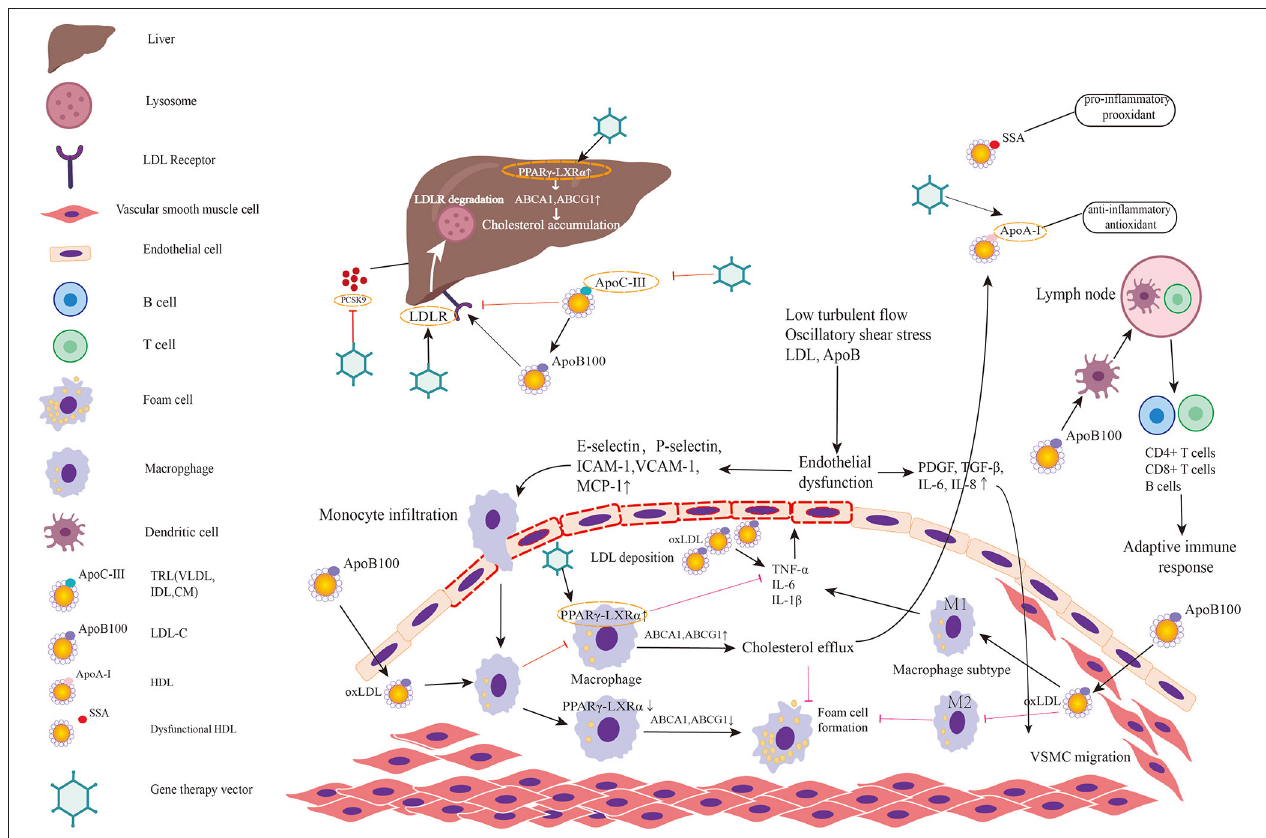
FIGURE 2 | Targets for gene therapy of atherosclerosis and involved mechanism. The figure predominantly demonstrates two primary mechanisms of atherosclerosis: (1) lipid metabolism; (2) immunoreaction and inflammation. Low turbulent flow, oscillatory shear stress, LDL, and ApoB in plasma induce endothelial dysfunction and activate the inflammatory response in endothelial cells. Then endothelial inflammation triggers the expression of leukocyte adhesion molecules such as E and P-selectin, intercellular adhesion molecule-1 (ICAM-1), vascular cell adhesion molecule-1 (VCAM-1) on endothelial cell surface. These molecules promote monocytes adhered to endothelial cells and infiltrated into subendothelial layer. Monocyte chemotactic protein-1 (MCP-1) also helps recruit circulating monocytes to migrate to intima. Thereafter, monocytes differentiate into macrophages and engulf the oxidative LDL. The excessive accumulation of oxLDL in macrophages leads to foam cell formation. When PPAR γ -LXR α in macrophage is upregulated, the overexpressed ABCA1 and ABCG1 promote cholesterol efflux to HDL, which is helpful to inhibit foam cell formation and prevent plaque progression. However, in pathologic conditions, PPAR γ -LXR α is down-regulated thereby promoting foam cell formation. Meanwhile, endothelial dysfunction leads to secretion of PDGF, TGF- β , IL-6, IL-8 initiating VSMC migration. Among two major subtypes of macrophage, M1 predominates in athersclerotic plaque and secrets inflammatory factors while M2 exerts anti-inflammatory effects and anti-atherogenic effects. Antigen-presenting cells present LDL and ApoB to T cells in lymph nodes to activate adaptive immune response. Lipid metabolism involved mechanism has been elucidated in the manuscript. Targets in existing gene therapy experiments investigating atherosclerosis are marked by gene therapy vectors. In summary, gene